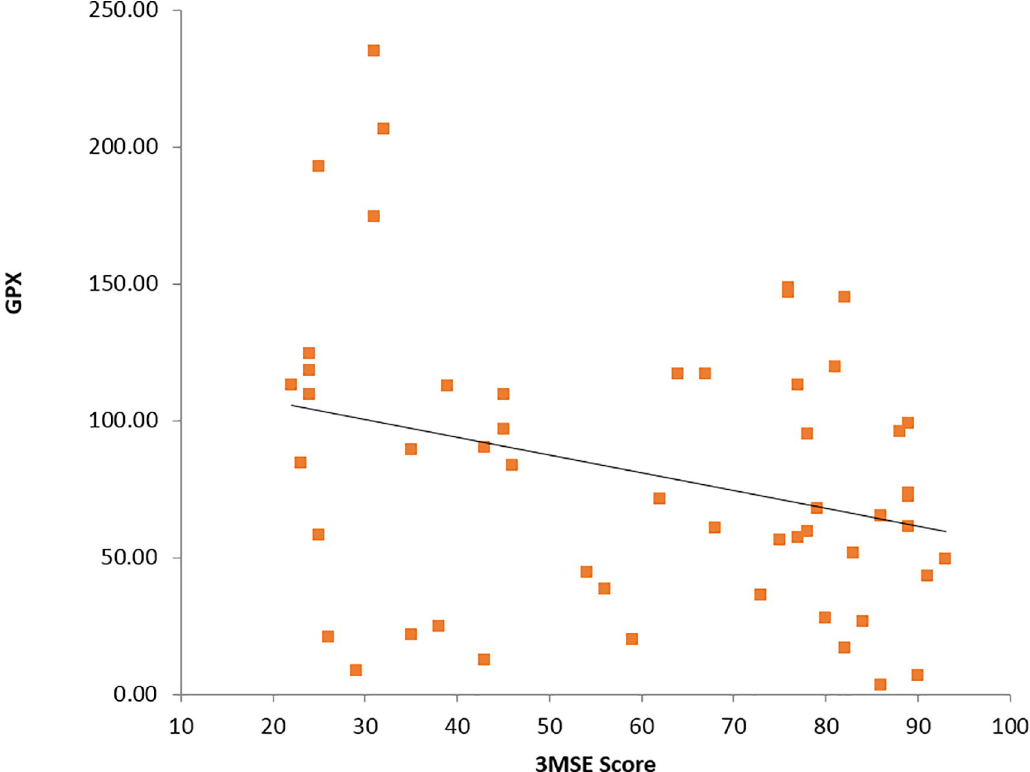
Fig 7. Correlation between 3MSE score and GPx in non-diabetics with vitamin D insufficiency.